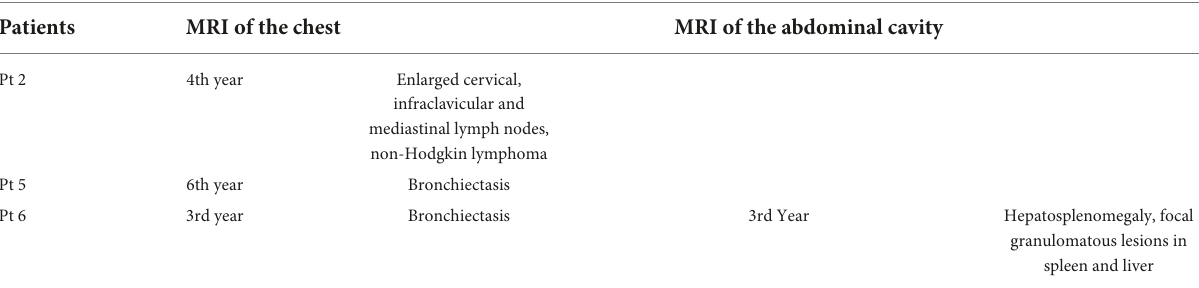
TABLE 4 Findings detected in magnetic resonance imaging (MRI) examinations of the abdominal cavity and the chest in ataxia-telangiectasia (A-T) patients and the time of observation. MRI